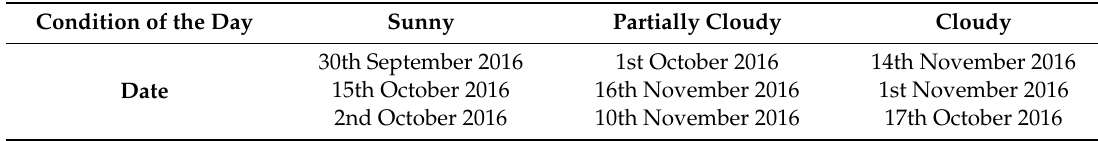
Table 3. Specified days for each condition of the day.